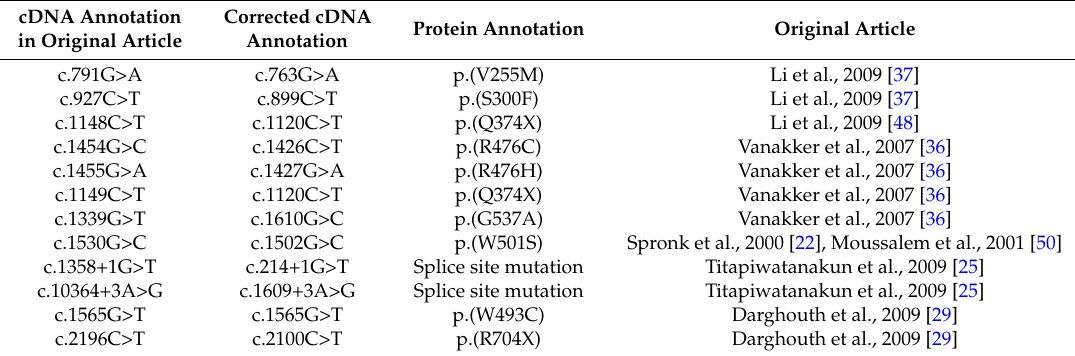
Table 3. Update of the mutation annotation according to reference sequence NM00082. In the original articles, reference sequence BC013979 was used (+1 located at the − 28 position of